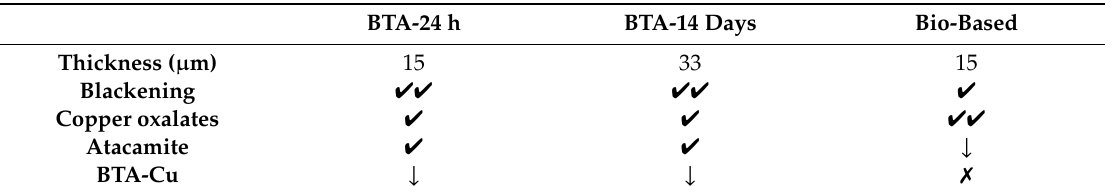
Table 5. Summary of the thickness and compounds detected on the samples treated with the coatings. Intense detection: (cid:52)(cid:52) ; normal detection: (cid:52) ; low detection: ↓ ; not detected: (cid:55) . BTA-24 h BTA-14 Days